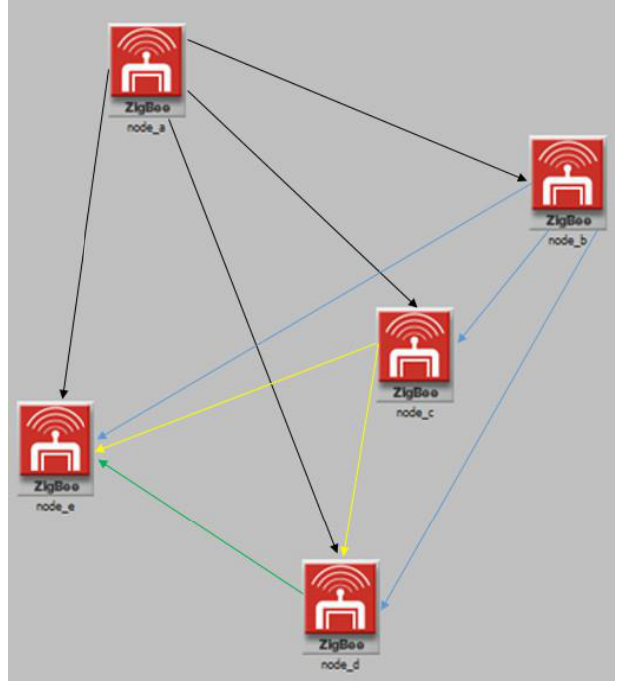
Figure 12. All the Nodes being Connected in the Network.